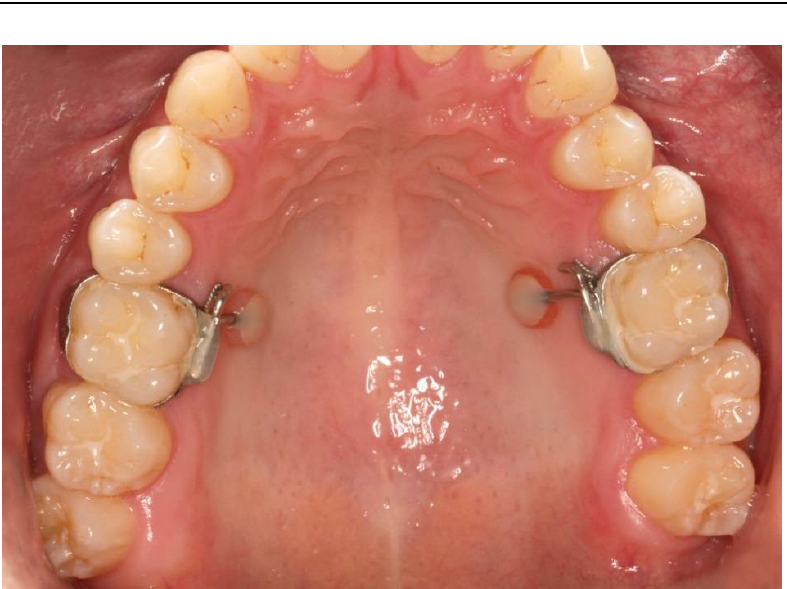
Figure 1. Intraoral test specimen after four weeks.